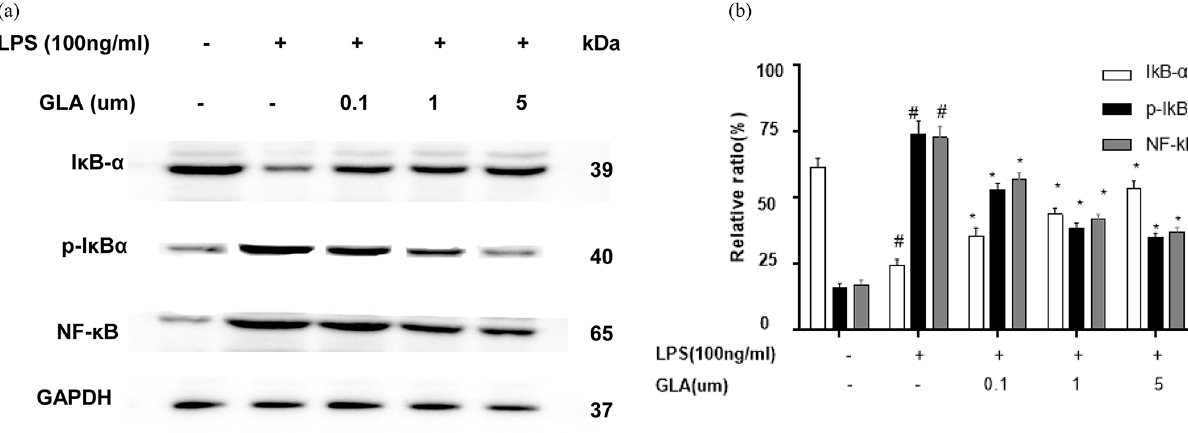
Figure 11: E ff ects of GLA on the expression of I κ B - α , p - I κ B α , and NF - κ Bp65. ( a ) Expression levels of I κ B - α , p - I κ B α , and NF - κ Bp65 in the LPS - stimulated RAW264.7 cells, in the presence or absence of GLA ( at indicated concentrations ) , were detected with Western blot analysis. ( b ) Statistical analysis of the expression levels of I κ B - α , p - I κ B α , and NF - κ Bp65. Compared with the SAL group, # P < 0.05; and compared with the LPS - treated group, * P < 0.05. N = 3; analyzed by